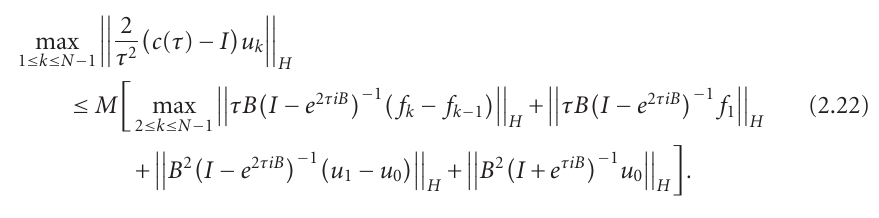
and the triangle